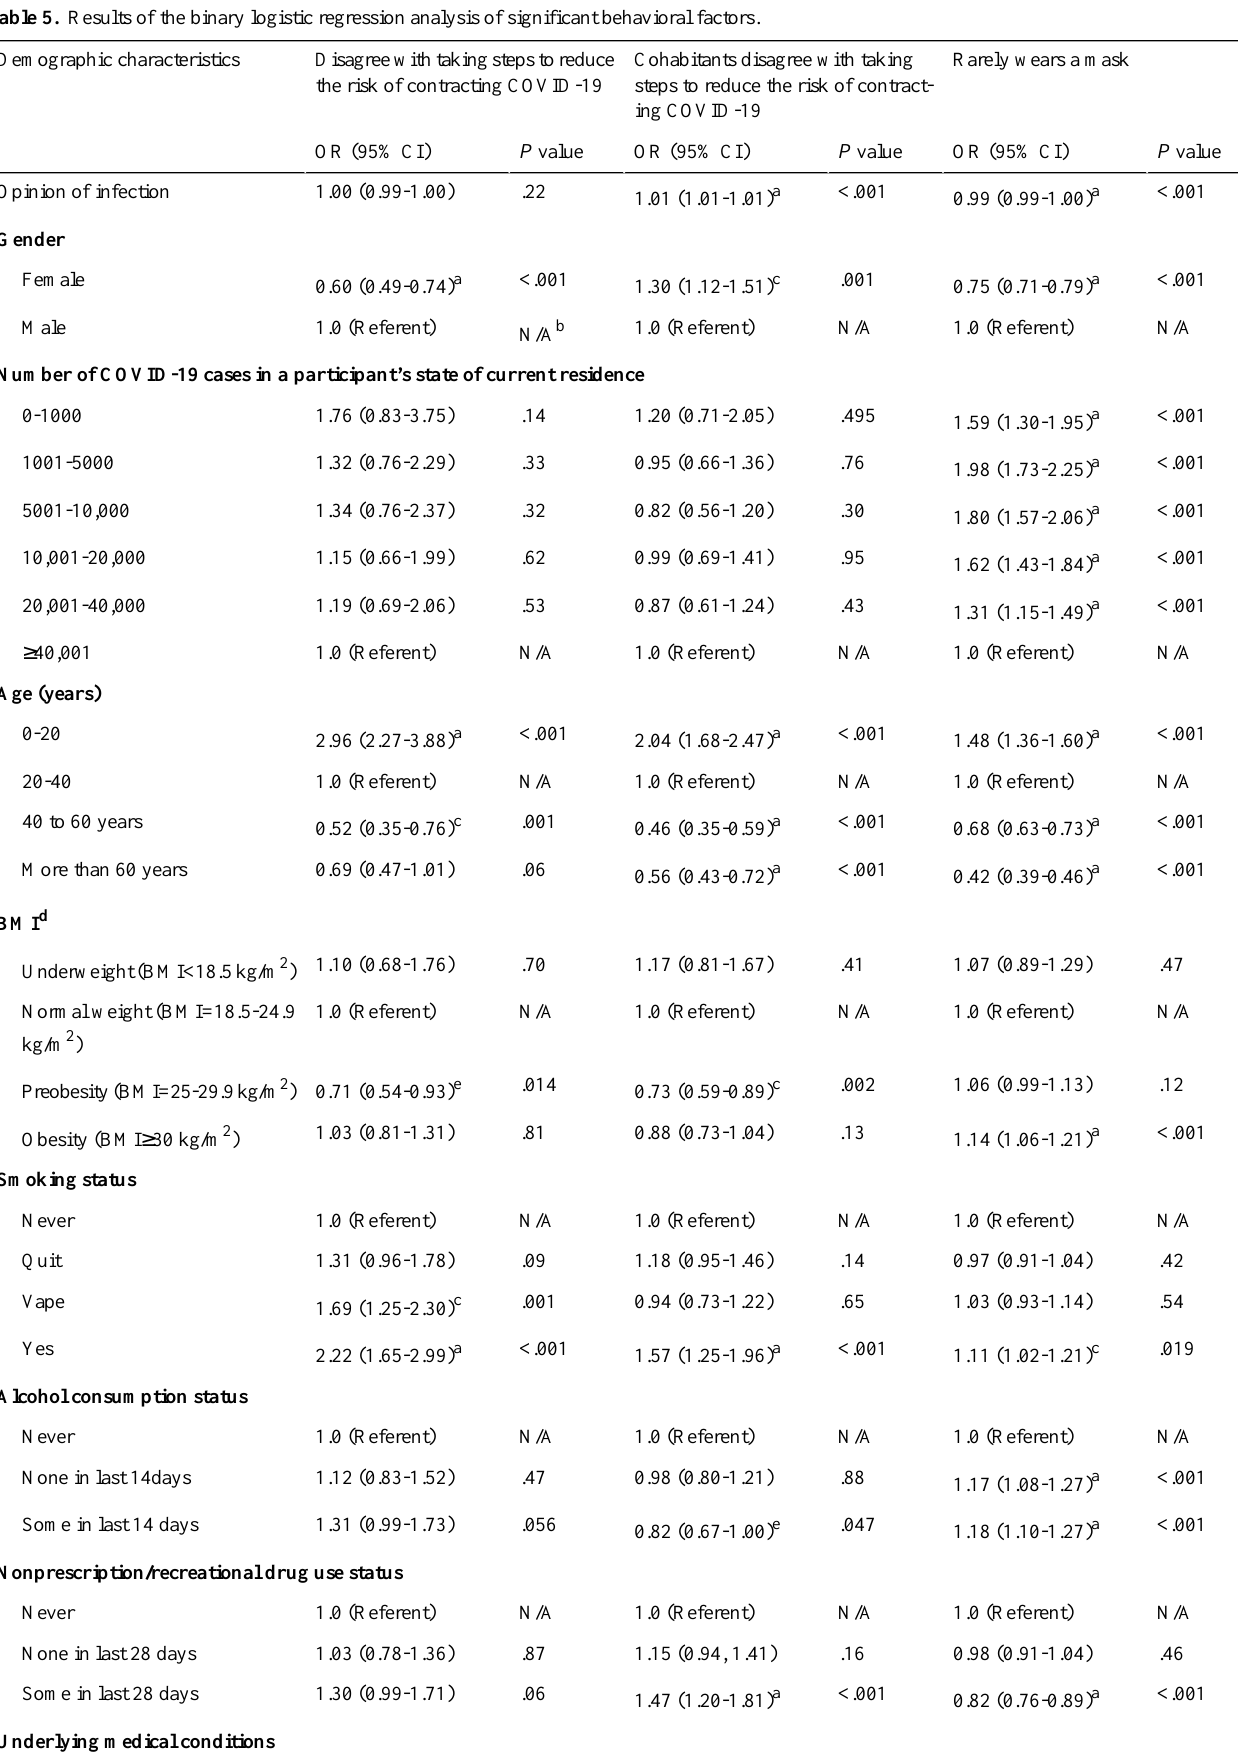
Table 5. Results of the binary logistic regression analysis of significant behavioral factors. COVID-19Demographic